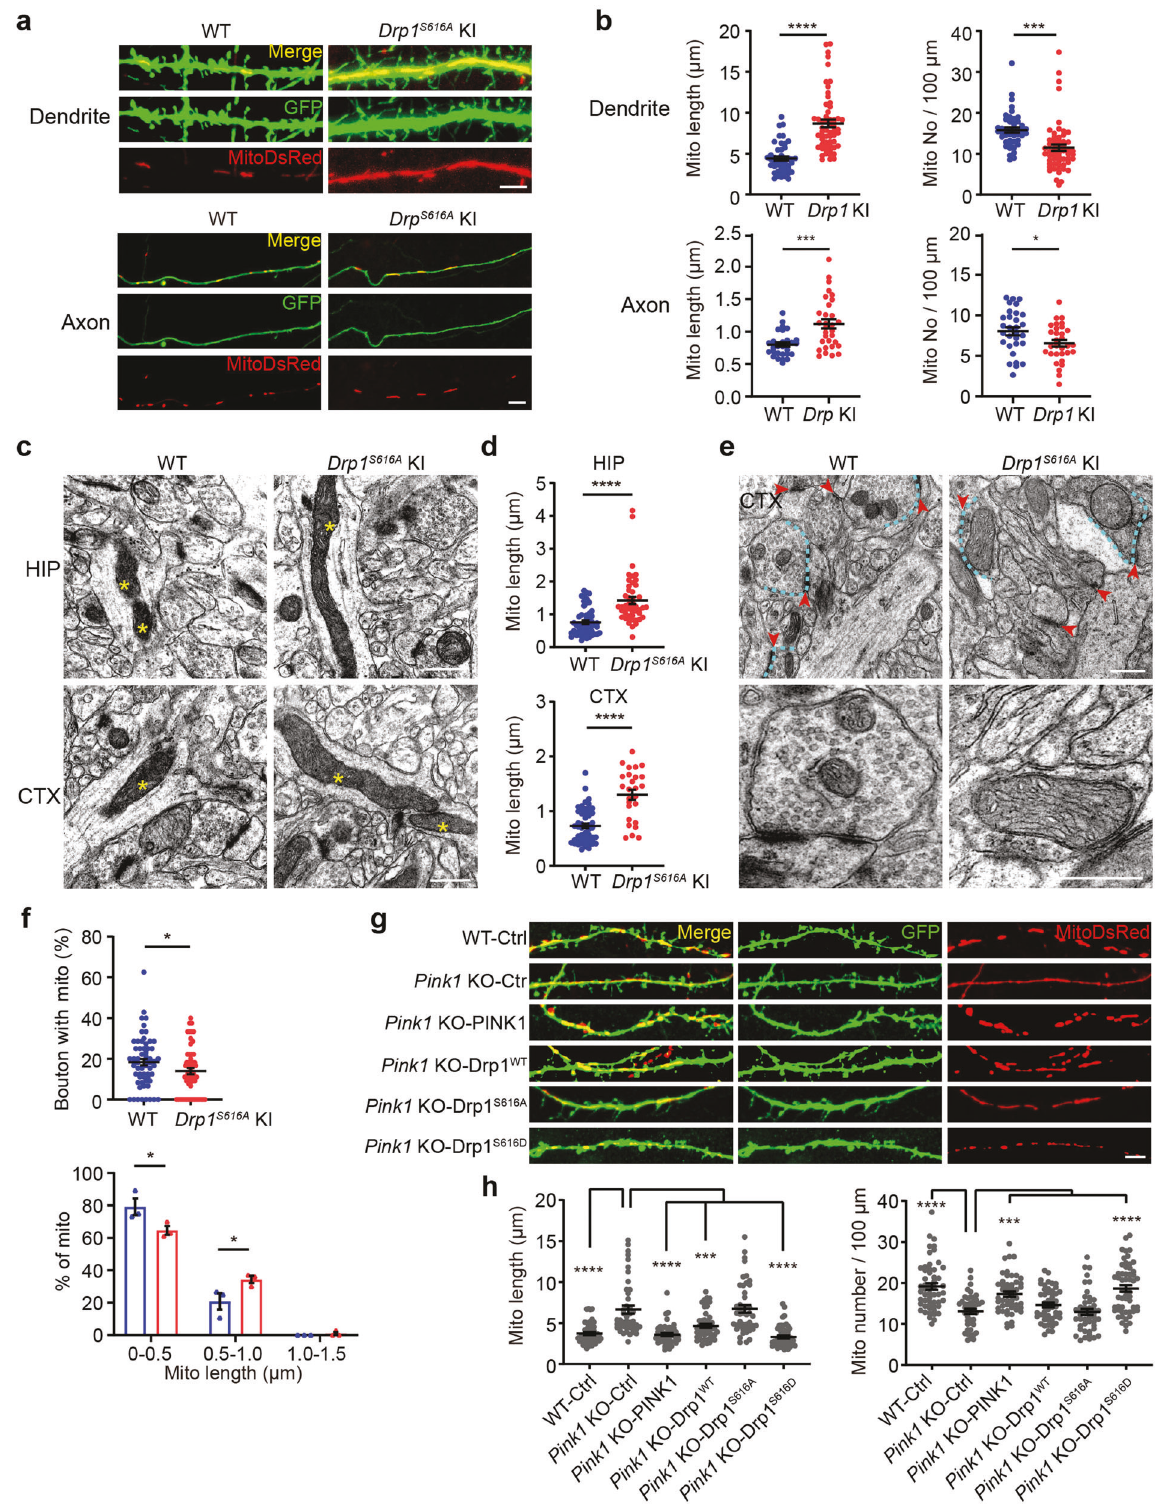
phosphorylating Drp1 S616 , resulting in modulation of matura- tion of synaptic circuit and synaptic plasticity for memory formation and consolidation. One potential mechanism sup- ported by this study is that PINK1/phosphor-Drp1 S616 -promoted dendritic mitochondrial fi ssion to generate smaller